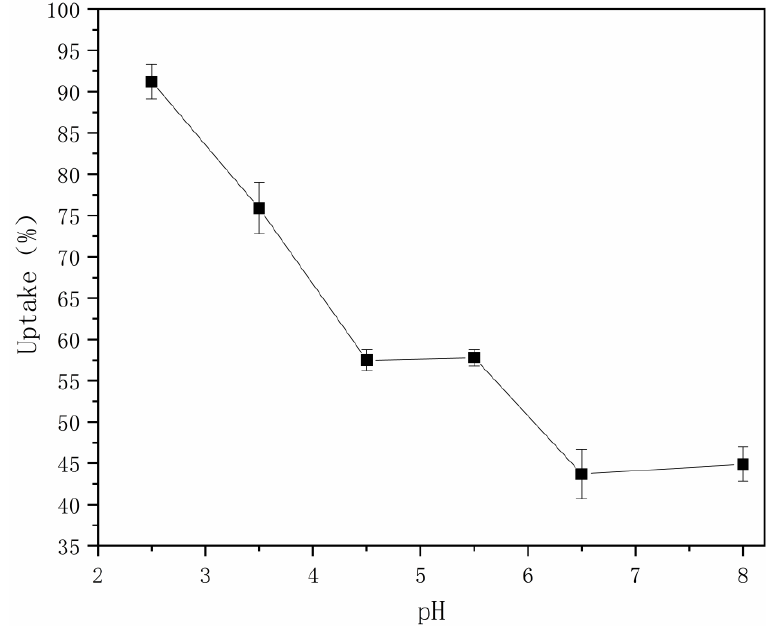
Figure 4. E ff ect of dyebath pH on Figure 4. Effect of dyebath pH on uptake.